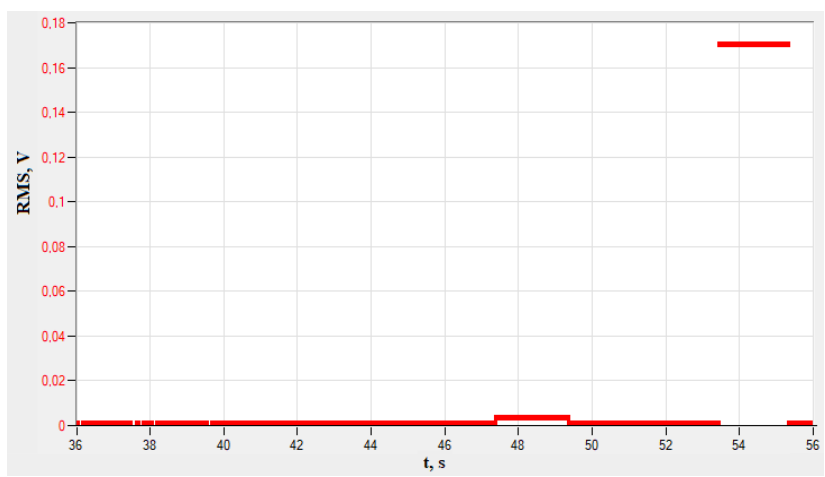
Figure 7. An example of changing average value of RMS as a function of time (PAC system)